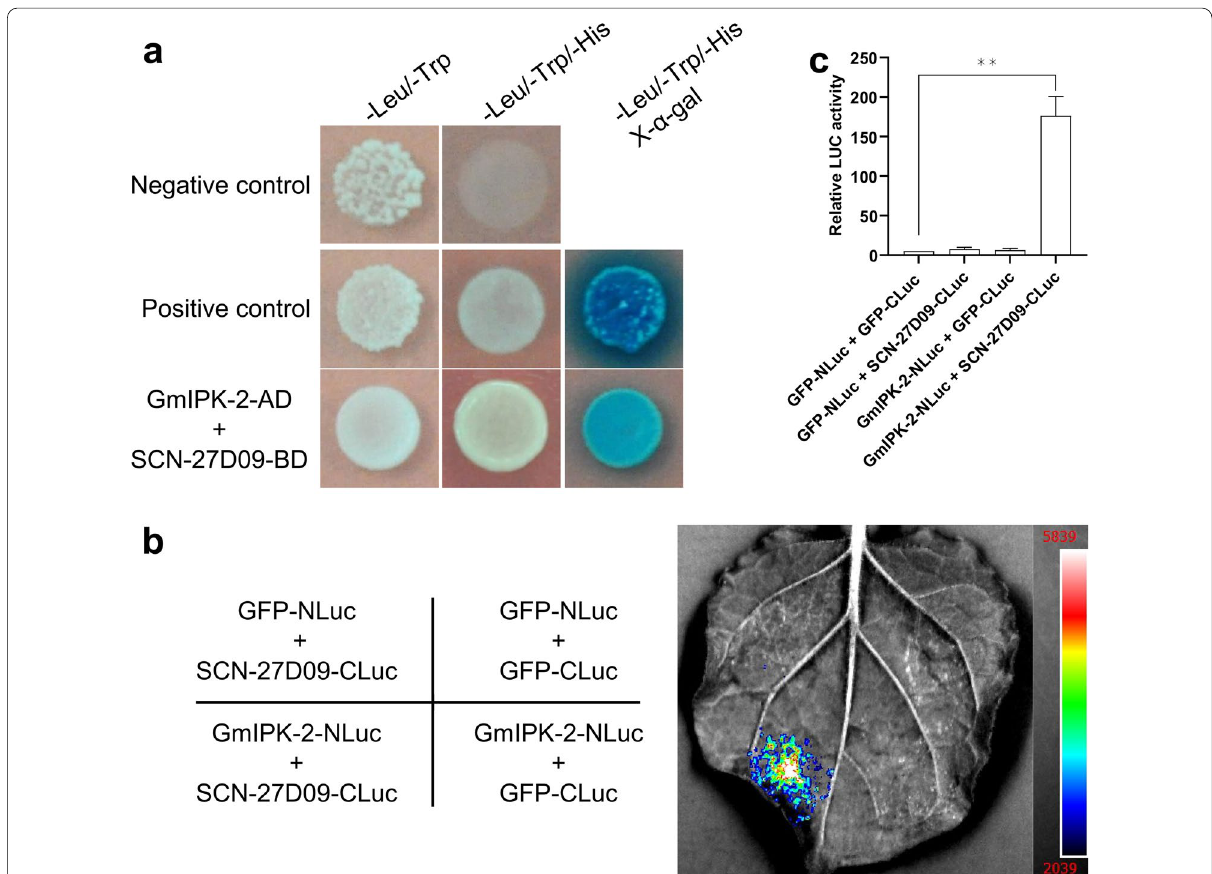
Fig. 5 SCN-27D09 interacts with GmIPK-2. a SCN-27D09 interacted with GmIPK-2 in yeast two-hybrid assay. The interaction between GmIPK-2-AD and SCN-27D09-BD activated the expression of HIS3 and LacZ reporter genes. The colony of positive control turned blue. b SCN-27D09 interacted with GmIPK-2 in luciferase complementation imaging (LCI) assay. GmIPK-2-NLuc and SCN-27D09-CLuc were transiently expressed in N. benthamiana by co-infiltration. The combination of GFP-NLuc and GFP-CLuc was used as negative control. The luminescence was detected with a low-light cooled CCD imaging apparatus at 36 h after infiltration. c Quantification of the LUC activity in the leaves shown in b . N GmIPK-2-NLuc/SCN-27D09-CLuc and control group values; ** P <